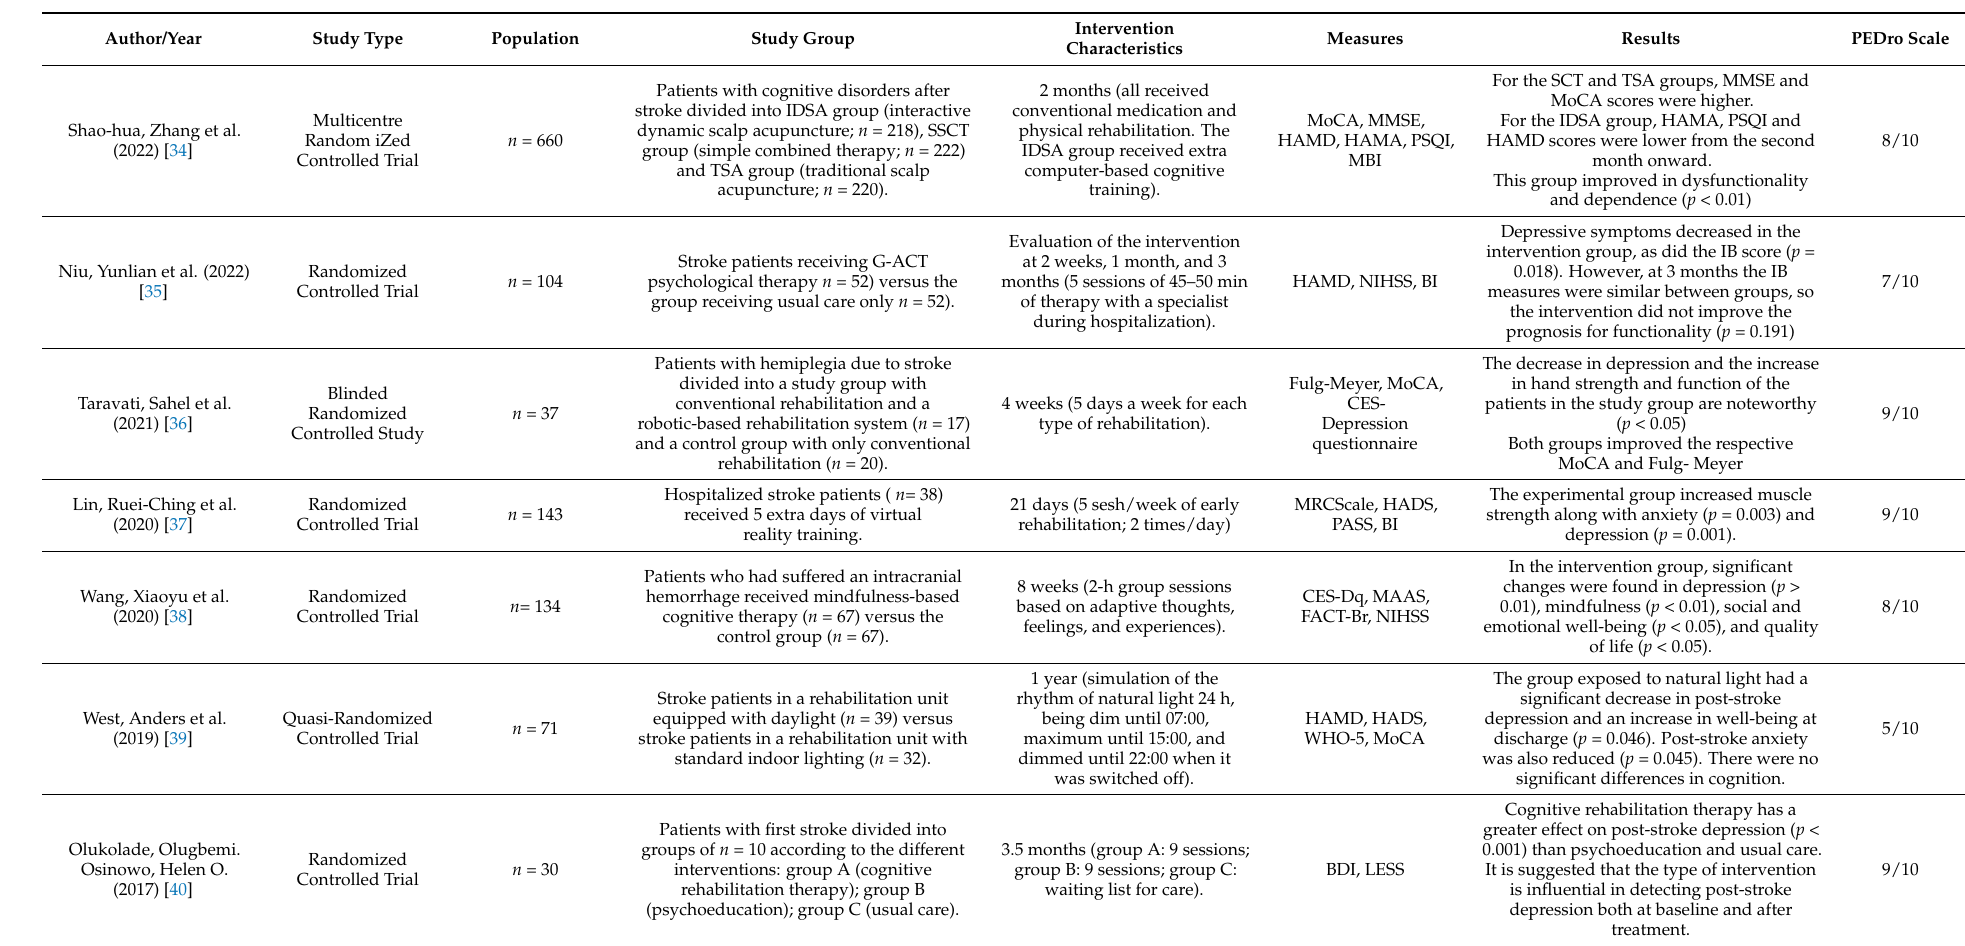
Table 3. Summary of the